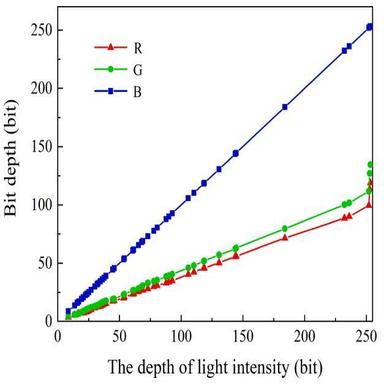
Color depth of silicon wafer under different light intensity depth.